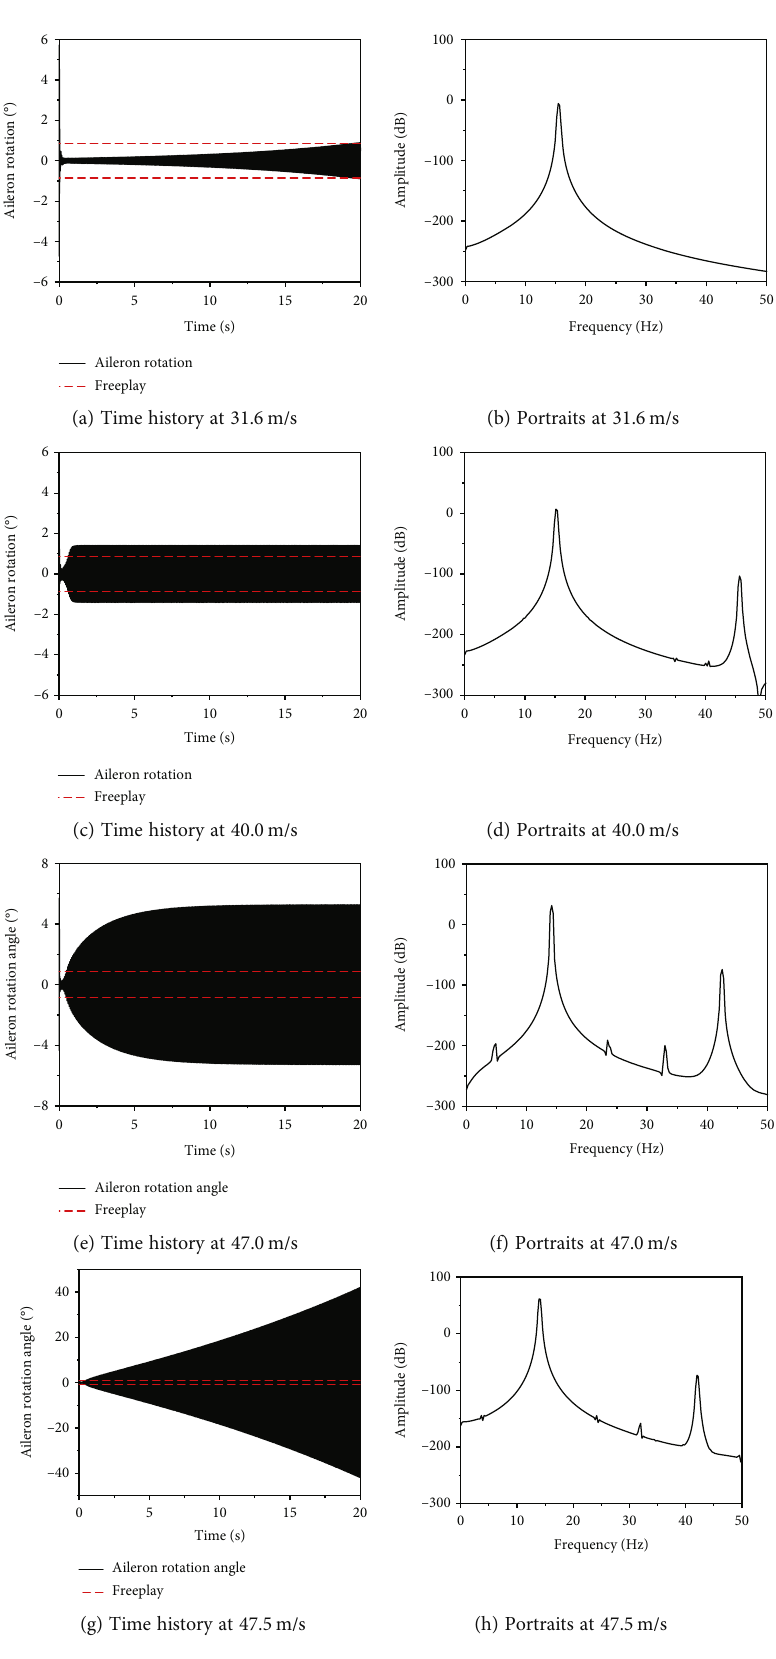
Figure 19: The angular displacement response of aileron rotational DOF (the freeplay interval in time history plot is depicted by two red dashed